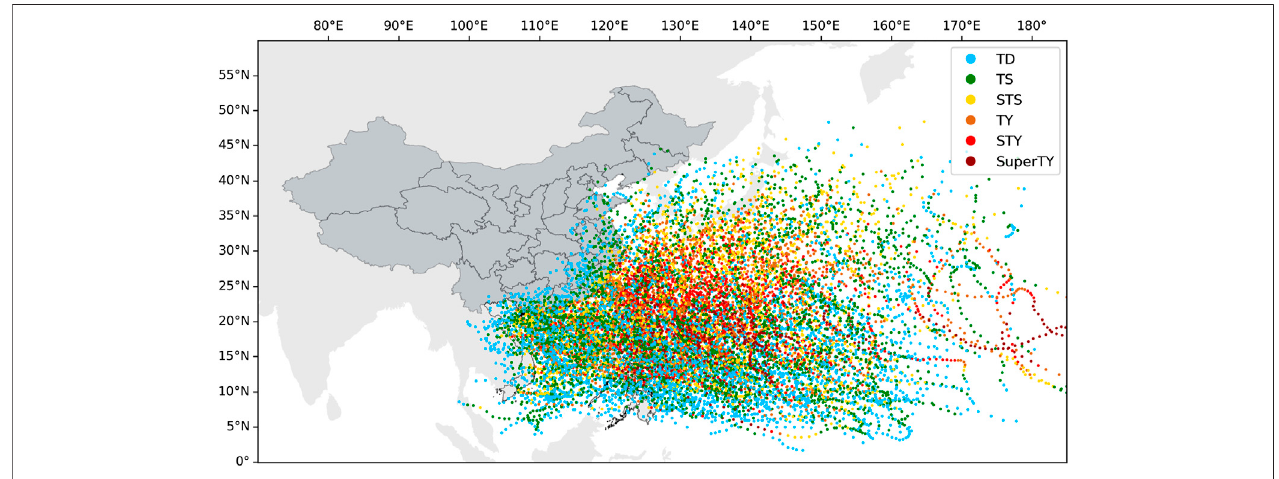
FIGURE 1 | Tracks of the TCs in the Western North Paci fi c from 2000 to 2019 based on the best track data from STI at 6-h interval.